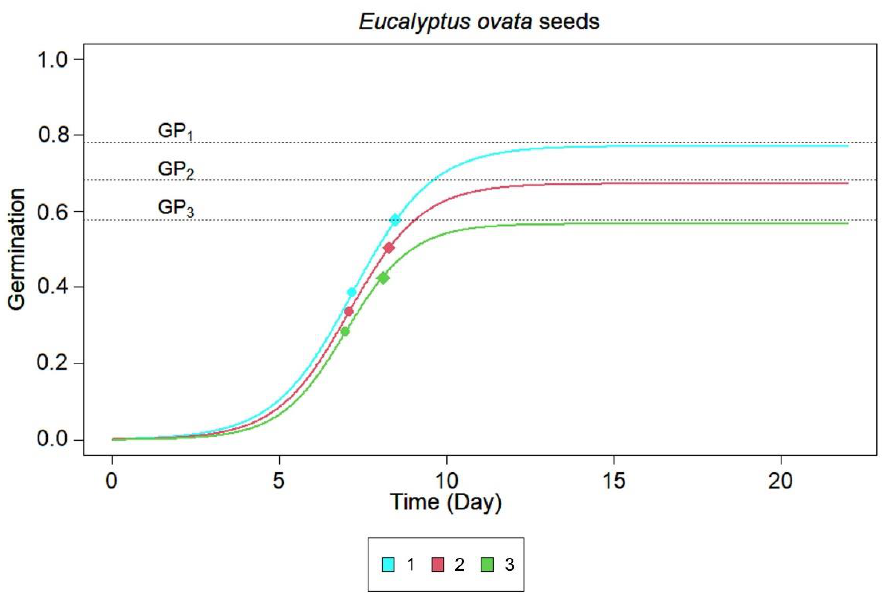
Figure 2. Temporal progression of Eucalyptus ovata seeds germination (range 0–1) for three substrates: 1—Filter paper; 2— P. undulatum soil; 3— Eucalyptus soil. On the x axis the days of the experiment (22 days) are reported. The horizontal asymptotes represent the total final germination ( GP i ) carried out for each substrate (i = 1–3), the coloured dots represent the inflection point (i.e., t 50 ) for each curve and the coloured diamonds represent t 75 (i.e., the time required to reach 3 / 4 of GP from relative t 50 ).